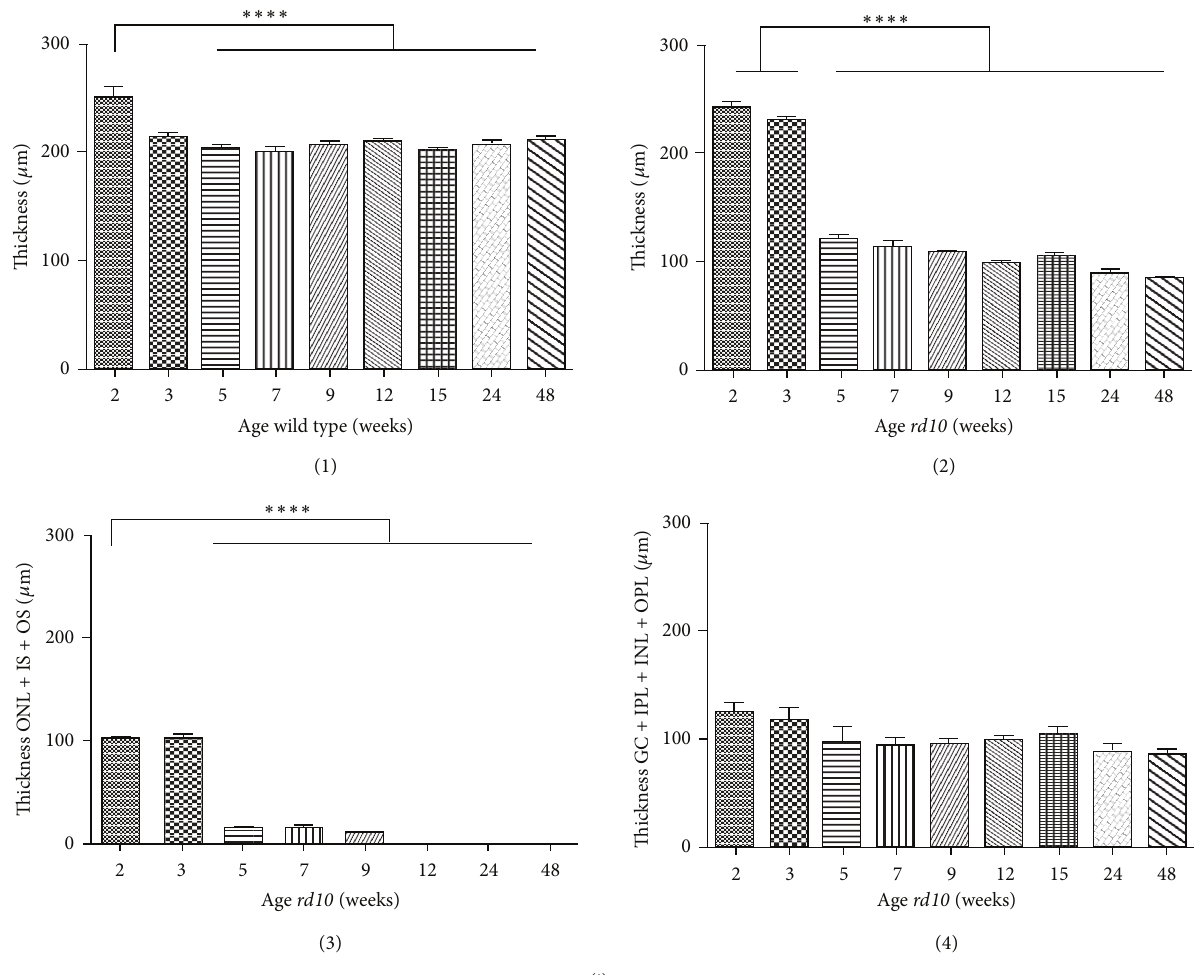
Figure 2: sd-OCT of wild type and rd10 mice. (a) Set-up. The mouse is positioned in front of the magnifying lens of the OCT on the chin rest of equipment usually used for application in humans. ((b)–(h)) OCT images of wild type and rd10 mice at different ages. All images are taken at the height of the papilla and displayed with the pigment epithelium to the top. Images of rd10 mice are printed in black on a white background (first column) as well as in white on a black background (second column). Red arrows in (b) (first column) demonstrate the evaluation of thickness at the height of the papilla by six averaged cuts through the retina. Red bars in ((c)–(f)) (first column) mark the outer nuclear layer (ONL). In (g) (first and second column) red stars indicate a separation of the retina from the pigment epithelium. Separation was only observed in vivo in two animals of nine and 24 weeks of age, respectively (g). (i) Evaluation of retinal thickness in wild type and rd10 mouse in the OCT. Values obtained from six cuts through the retina at the height of the papilla were averaged and plotted against the age (each age group: 𝑛 = 3 , both eyes per 𝑛 ). Thickness of the whole retina is illustrated in ((i)1) (= wild type) and ((i)2) (= rd10 mouse). ((i)3): thickness of ONL (outer nuclear layer, somata) + inner and outer segments of the photoreceptors (IS + OS). In ((i)4), retinal thickness except photoreceptor layers is illustrated (GC = ganglion cell layer, IPL = inner plexiform layer, INL = inner nuclear layer, and OPL = outer plexiform layer). Values represent mean ± SD ((i)1) (wild type) for animals at the age of 2 weeks: ∗∗∗∗ 𝑃 < 0.0001 versus animals older than 5 weeks; ((i)2) ( rd10 ) for animals of 2 and 3 weeks ∗∗∗∗ 𝑃 < 0.0001 versus animals older than 5 weeks; ((i)3) ( rd10 ) for animals of 2 weeks ∗∗∗∗ 𝑃 < 0.0001 versus animals older than 5 weeks; one-way ANOVA with Bonferroni’s post hoc